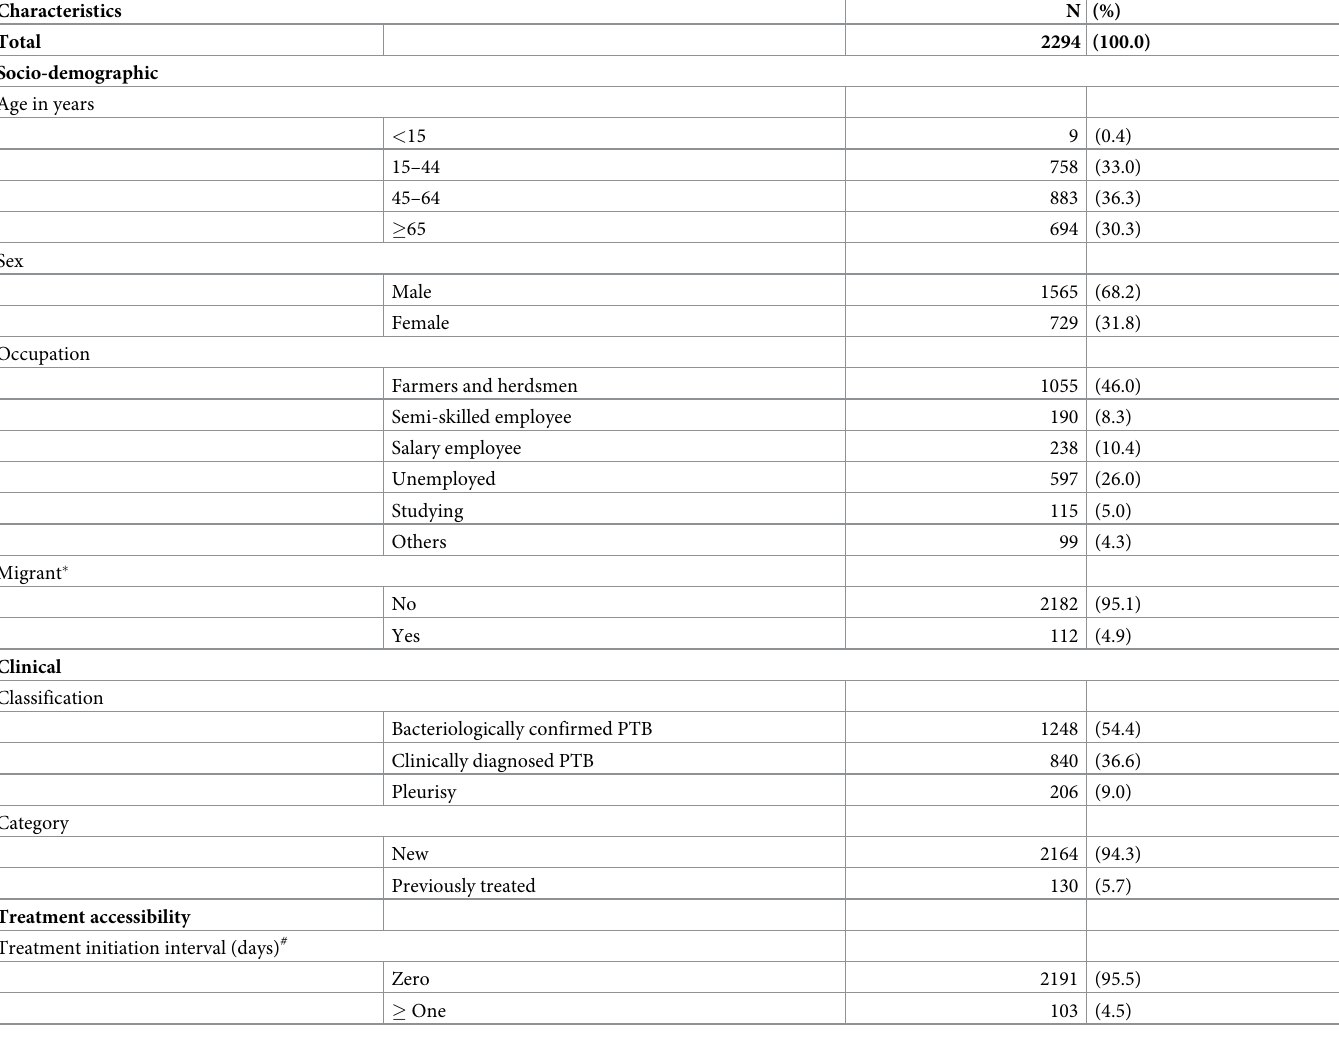
Table 1. Socio-demographic, clinical and treatment accessibility related characteristics of notified people with TB in the 30 selected counties of China between July and December, 2018.